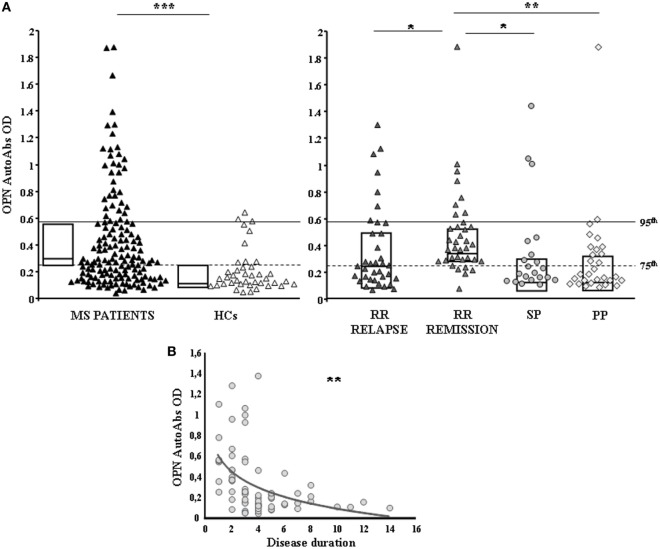
Anti-OPN autoantibodies (autoAbs) are increased in relapsing–remitting (RR) patients compared with secondary-progressive (SP) and primary-progressive (PP) patients and healthy controls (HCs). (A) AutoAbs to osteopontin (OPN) in multiple sclerosis (MS) patients and HCs. AutoAbs detected by ELISA using OPN full-length as the capture protein. In the left panel, black triangles mark MS patients and white triangles the HCs. In the right panel, patients are stratified according to their clinical form at the time of blood withdrawal. Dark gray triangles: RR-relapse MS patients; light gray triangles: RR-remission MS patients; gray circles: SP-MS patients; gray diamonds: PP-MS patients; boxes: interquartile range with medians. p Values were calculated with the Mann–Whitney U-test. The horizontal lines indicate the 75th (dashed line) and 95th (continuous line) percentiles of the HCs. (B) Inverse correlation between autoAbs to OPN and disease duration in RR patients (Pearson correlation test) (*p < 0.01, **p < 0.001, ***p < 0.0001).